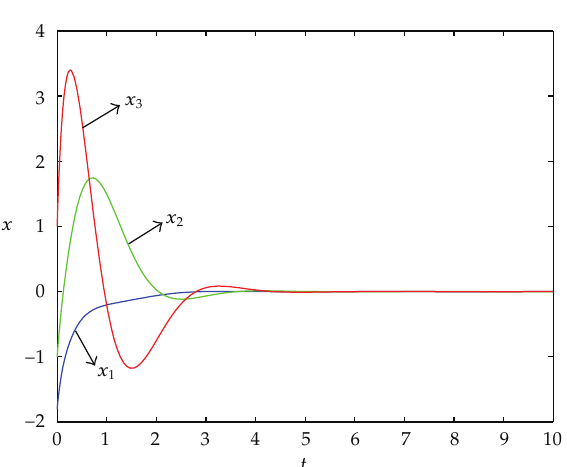
Figure 2: Time response of system (cid:2) 4.1 (cid:3) with the piecewise linear state